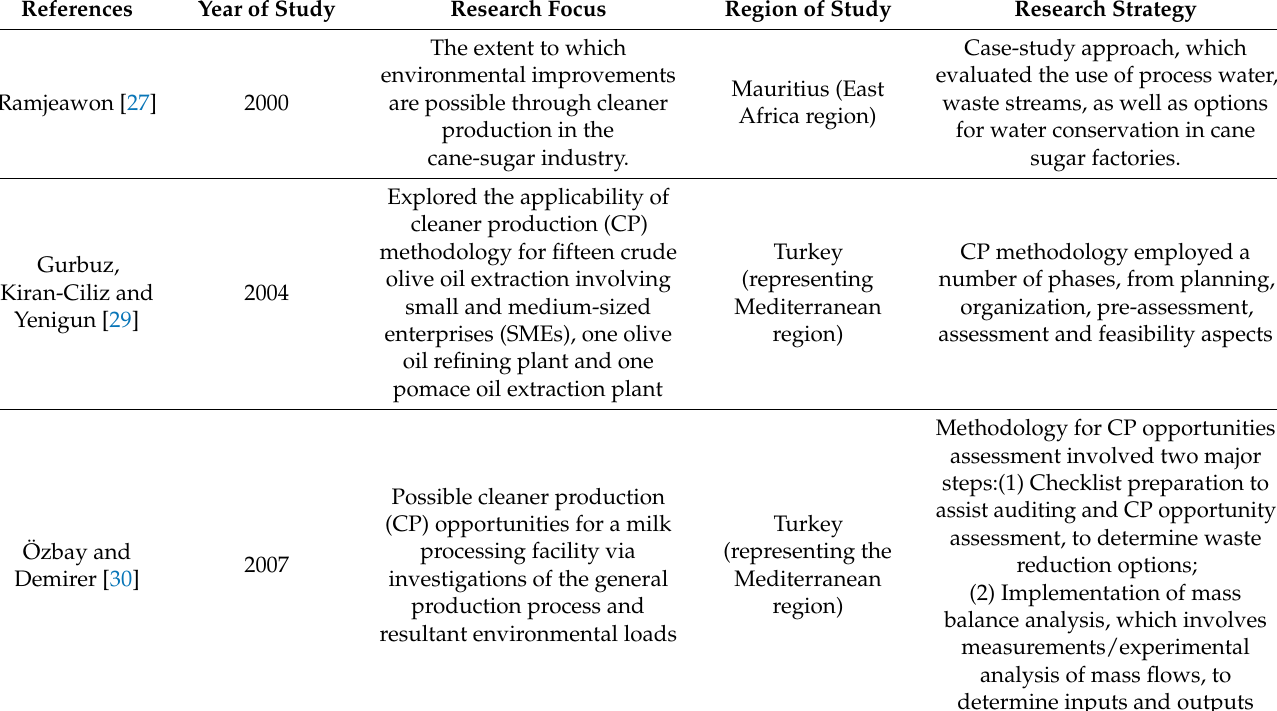
Table 1. Summary of some cleaner production implementation involving diverse sectors of the agrofood product industry specific to research focus, and region of study, as well as (research)